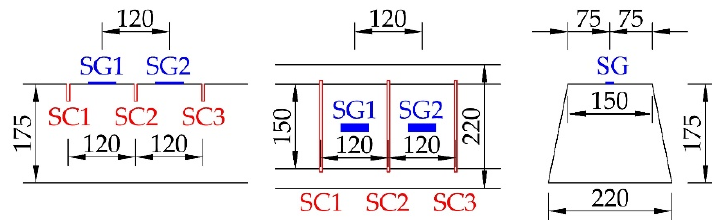
Figure 8. Position of saw-cuts (SC) and strain gauges (SG).